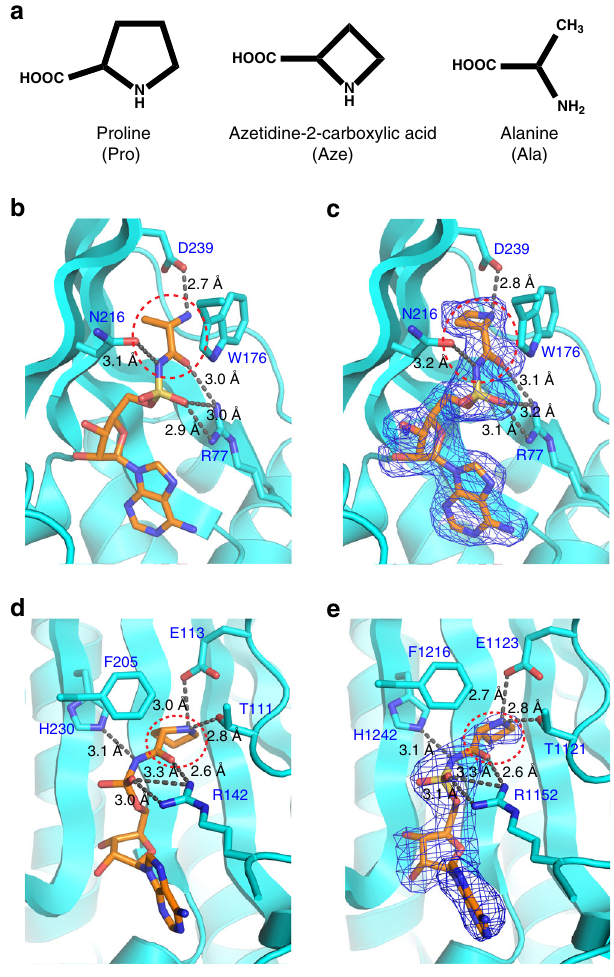
Fig. 1 Aze fi ts in the active site of both Hs AlaRS and ProRS. a Structures of proline (Pro), azetidine-2-carboxylic acid (Aze), and alanine (Ala). Structure of Hs AlaRS with b Ala-SA or c Aze-SA in the active site. d Tt ProRS structure with Pro-SA in the active site. e Hs ProRS structure with Aze-SA in the active